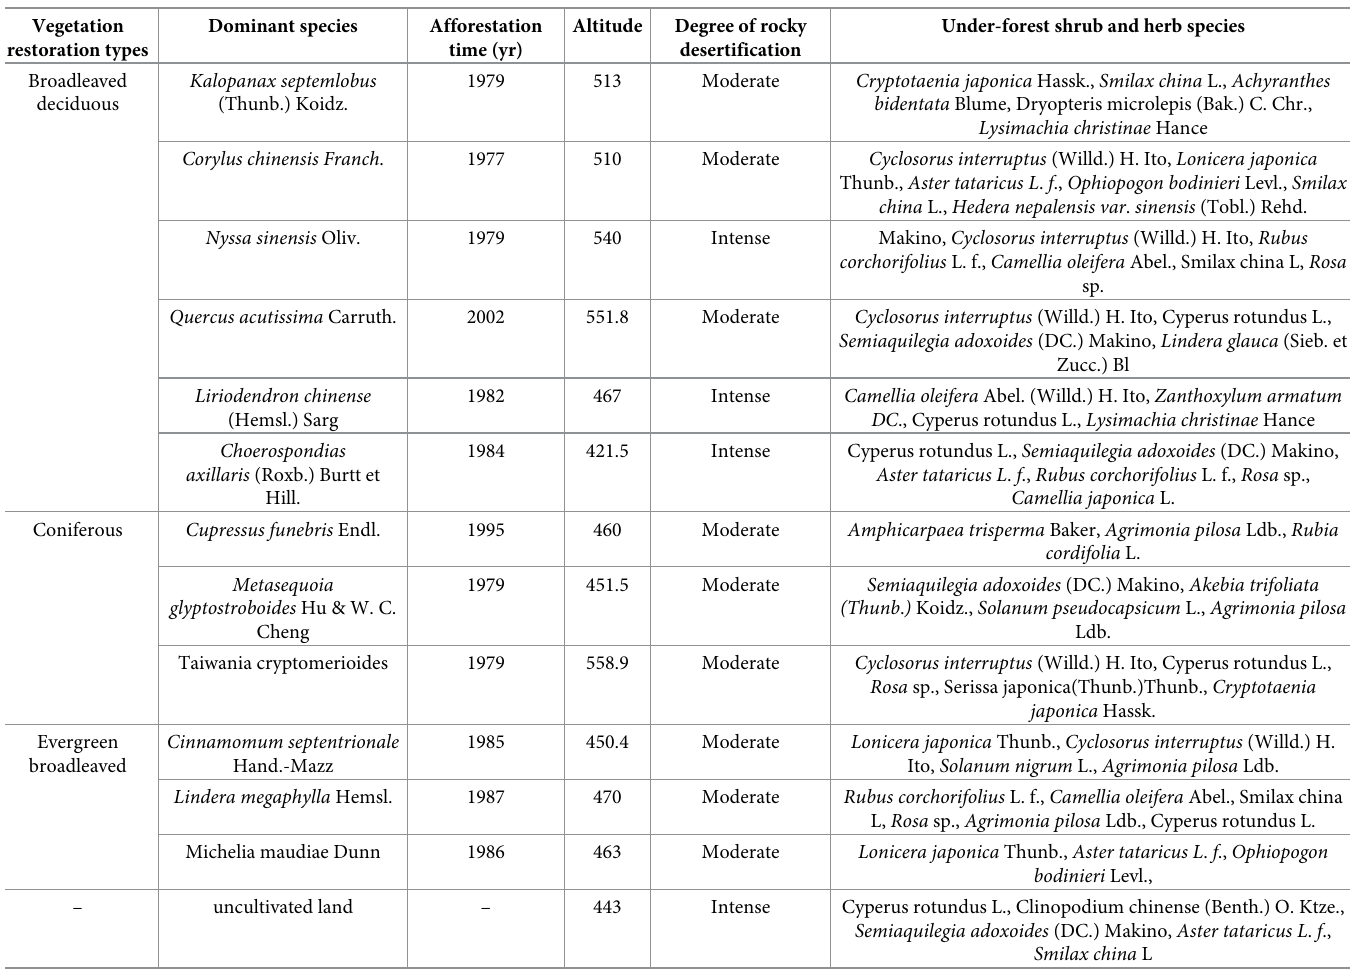
Table 1. Study area information of different vegetation